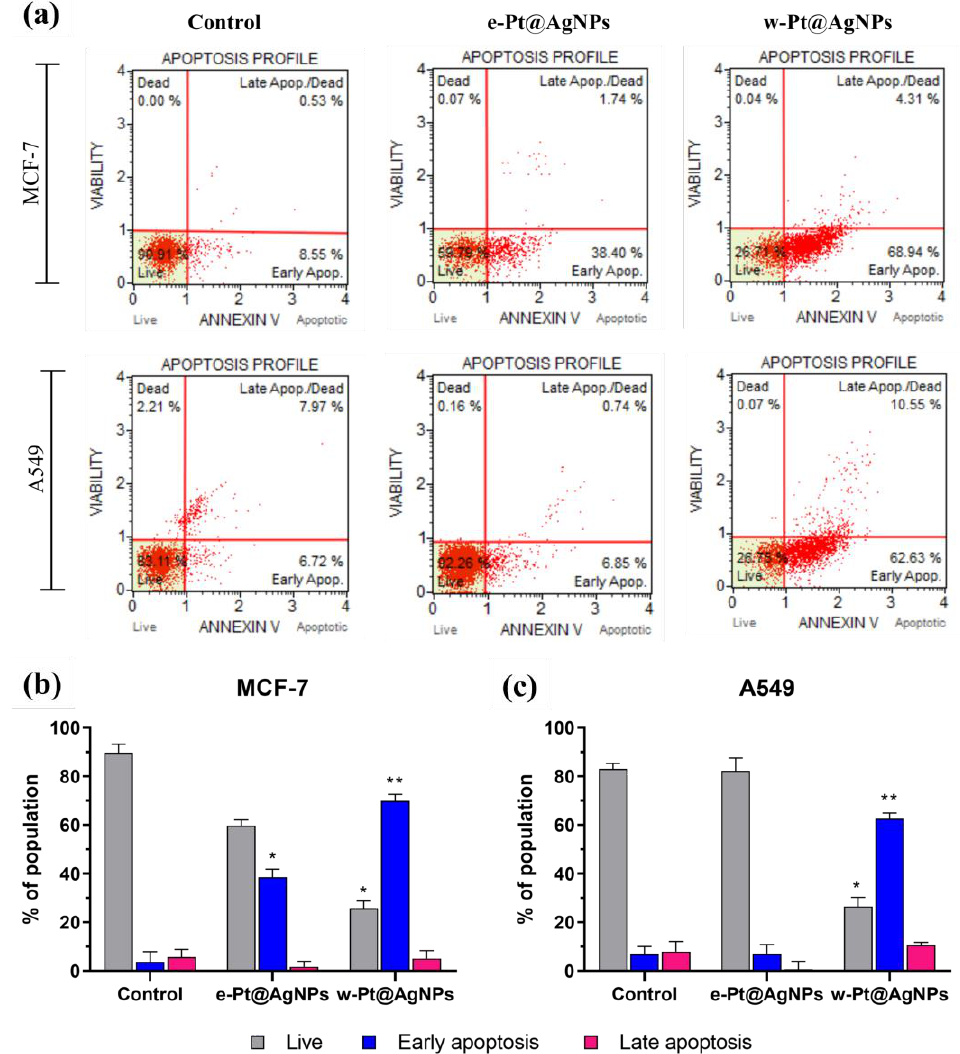
Figure 8. ( a ) Representative apoptotic profile plots of e -Pt@AgNPs and w -Pt@AgNPs on MCF-7 and A549 cells. Flow cytometric analysis showing the percentage of the cell population of ( b ) MCF-7 and ( c ) A549 cells following incubation with e -Pt@AgNPs and w -Pt@AgNPs for 24 h. Untreated cells are denoted as control. Data presented as mean ± SD with the differences * p < 0.05 and ** p < 0.01 considered significant.